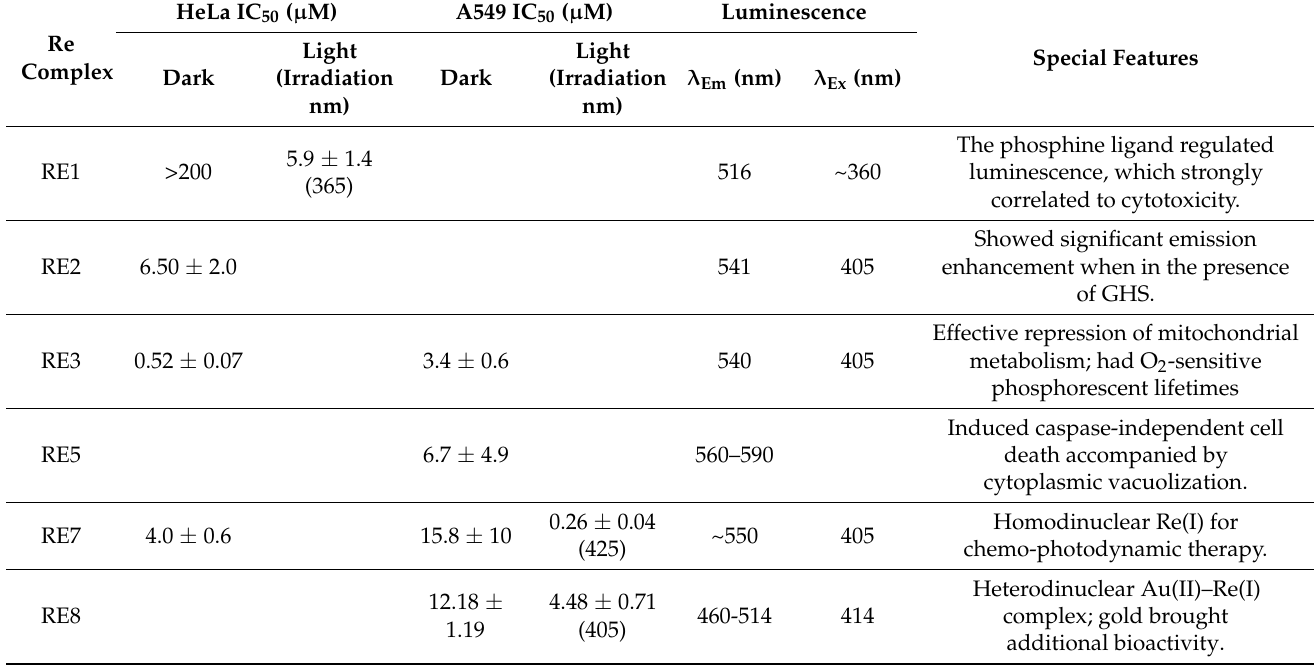
Table 4. A summary of the IC 50 values, luminescent properties and special features of rhenium(I) luminescent complexes: phosphine ligated complex RE1 [93], GHS-responsive bio-sensing complex RE2 [94], mitochondrial-targeted theragnostic complex RE3 [96], rhenium(I) aqua complex RE5 [98], heterodinuclear Re(I) β -carboline complex RE7 [100], and gold(II)/rhenium(I) heterodinuclear com- plex RE8